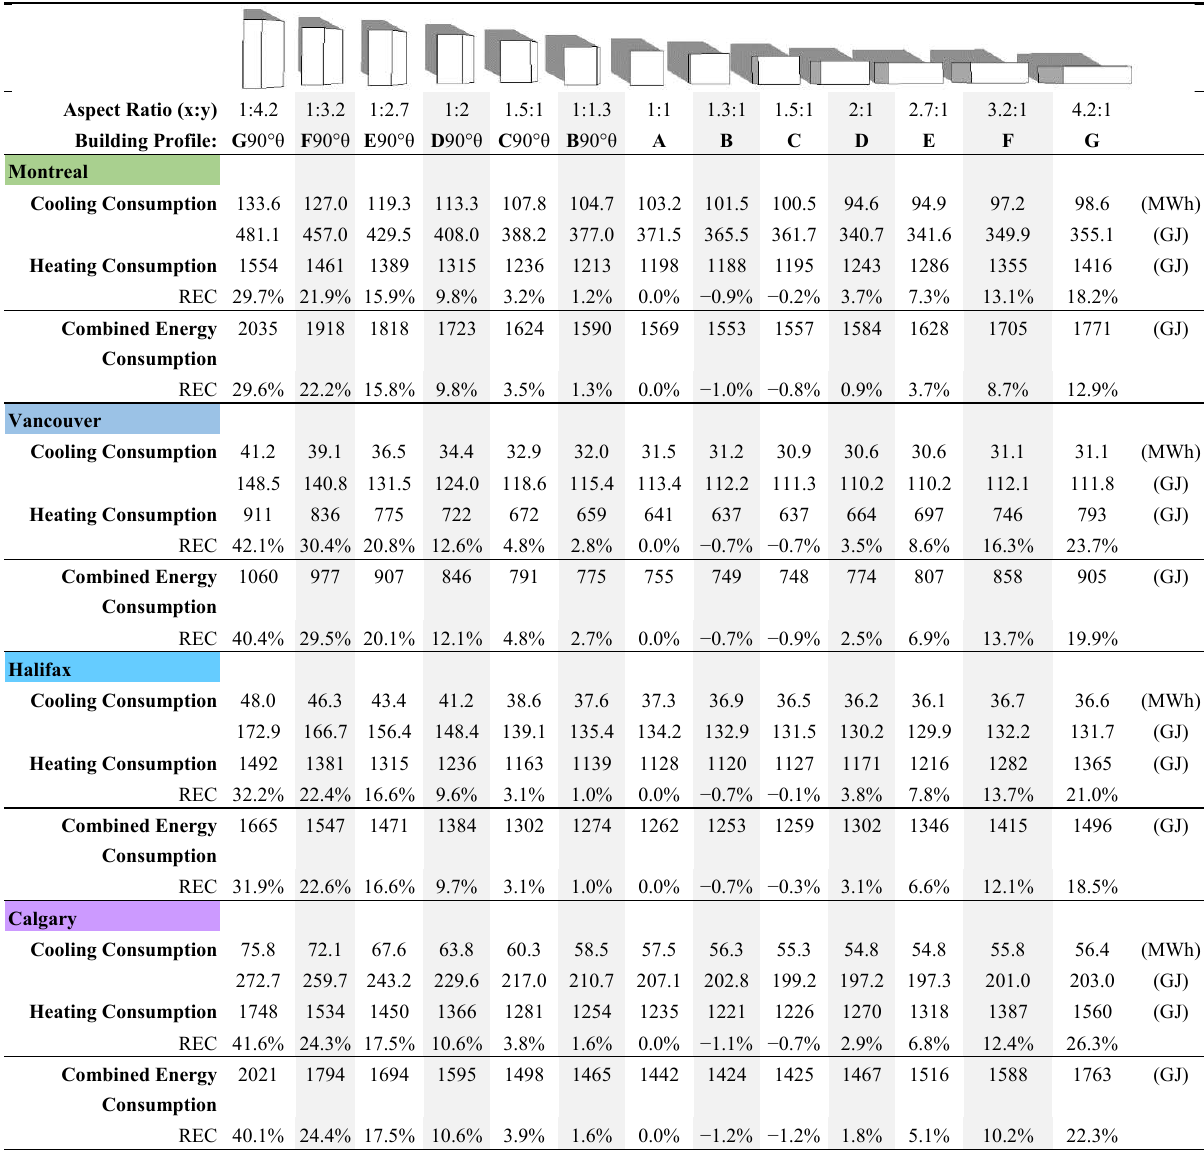
Table 5. Model simulation results: total annual energy consumption. REC, relative energy